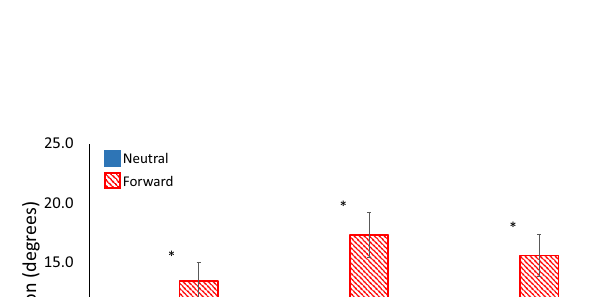
Table 1 Effect of head position on reaction times and